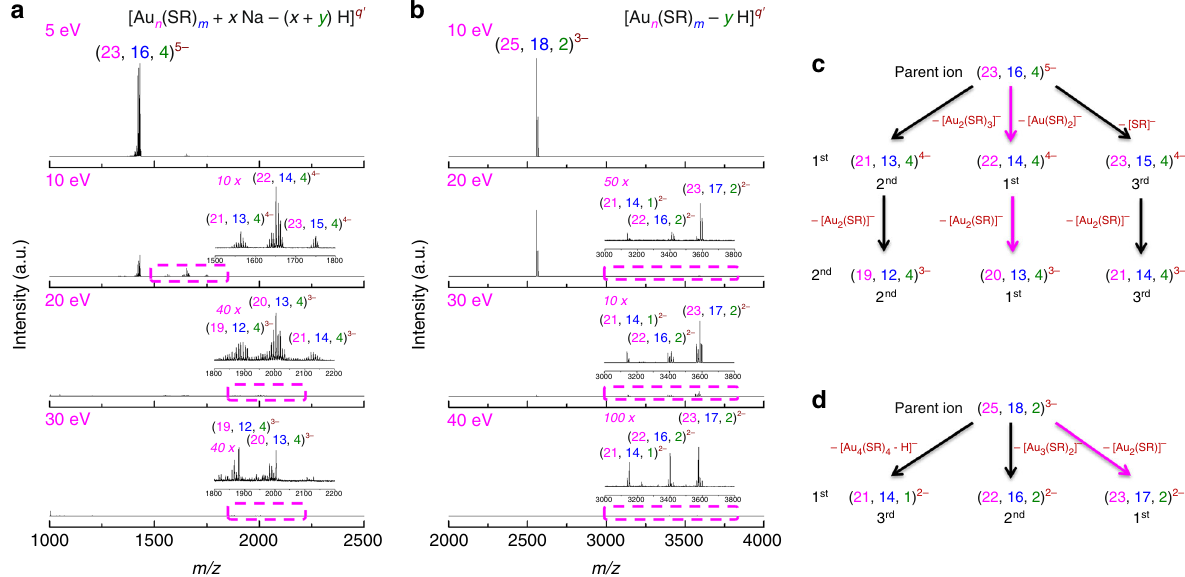
Fig. 5 Structural relatedness between Au 23 and Au 25 nanoclusters. a , b Tandem mass spectra and c , d fragmentation pathways of a , c [Au 23 (SR) 16 ] − and b , d [Au 25 (SR) 18 ] − . SR denotes thiolate ligand. For clarity purpose, the cluster and fragment cluster ions [Au n (SR) m + x Na – ( x + y ) H] q ’ are referred to as ( n , m , y ) q ’ . The applied collision energies are indicated at the left-top corner of each spectrum in a , b , while the inset in each row shows boxed area in the corresponding spectrum. The abundance order of the fragment cluster ions is summarized underneath the corresponding ions, whereas the dominant fragmentation pathways are highlighted by the magenta